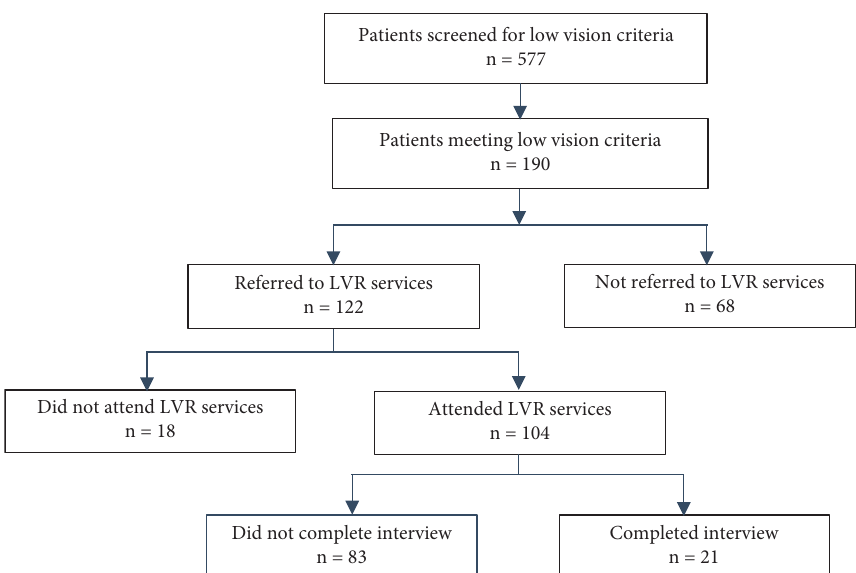
Figure 1: Eligible low-vision patients screened, referred, and interviewed. LVR � low-vision rehabilitation.